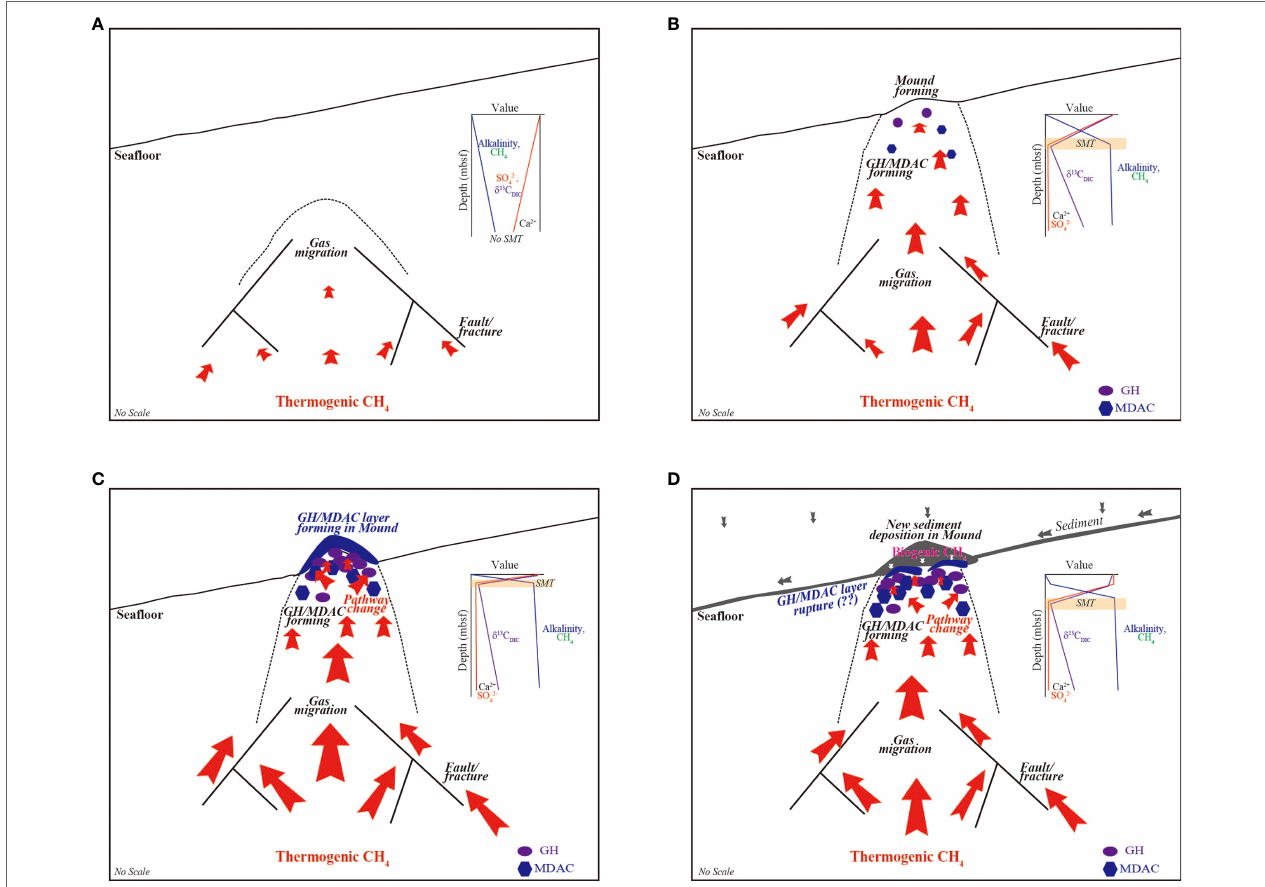
FIGURE 7 | Schematic diagram illustrating the change of seafloor morphology, fluid and gas migration, fluid chemistry (SO 42- , alkalinity, Ca 2+ , CH 4 , and δ 13 C DIC ), and MDACs and GHs production in the ARAON Mounds in association with the CH 4 flux; (A) beginning of the upward CH 4 flux from the deep sediment, (B) mound formation on the seafloor and beginning of GH and MDAC production in the sediment column under high upward CH 4 flux, (C) GH and MDAC production in the seafloor and flow pathway change under a high upward CH 4 flux, and (D) new sediment deposition at the mound and/or GH and MDAC production under a high upward CH 4